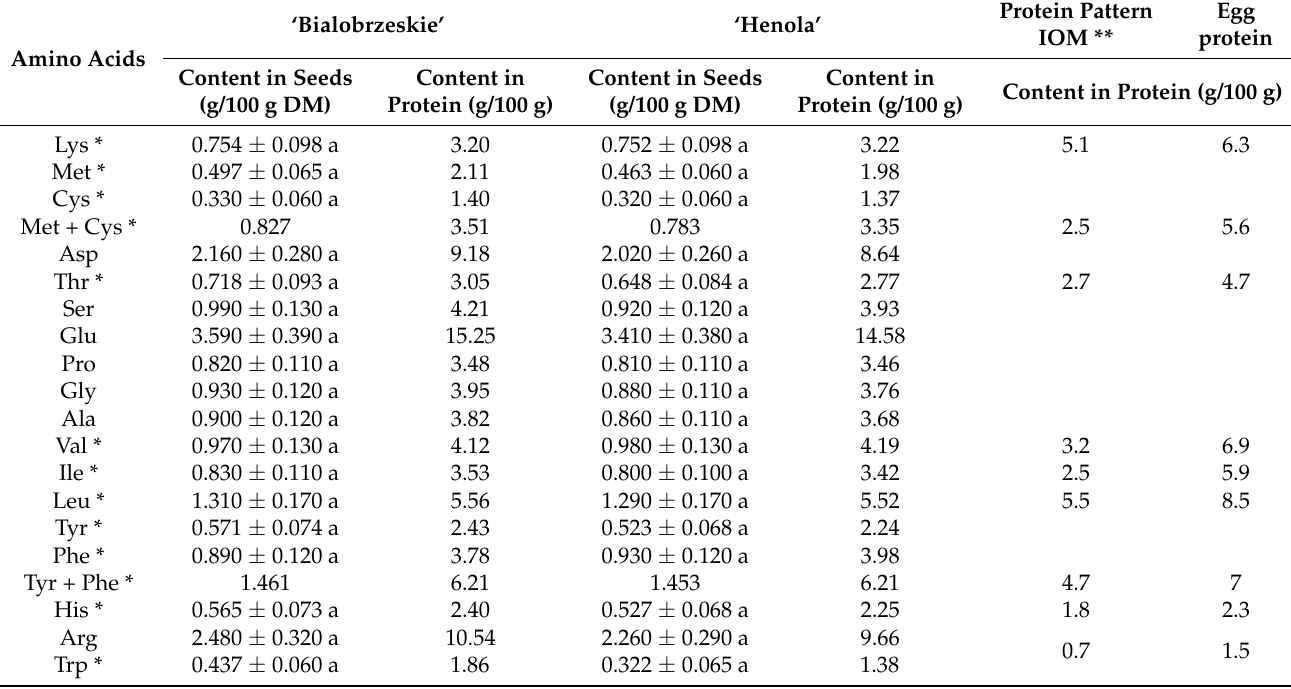
Table 4. Amino acid profile of hemp